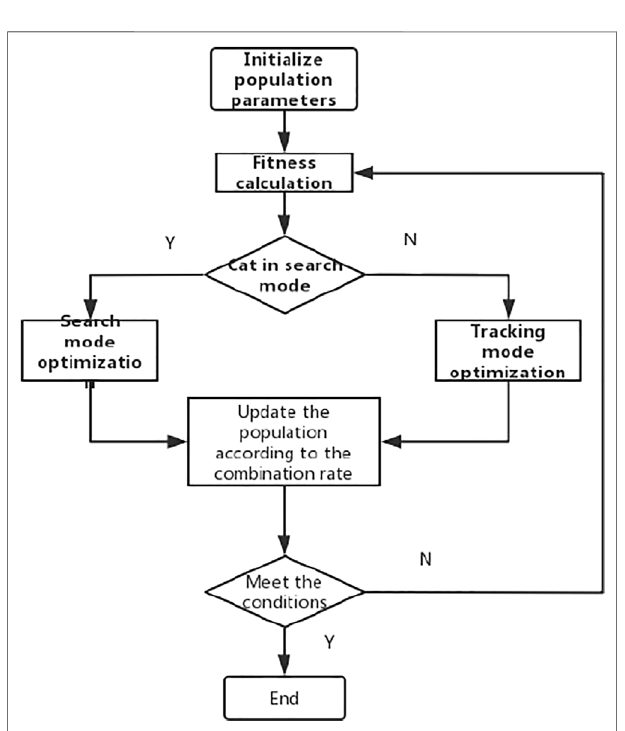
FIGURE 2 | Flow chart of the CSO algorithm.